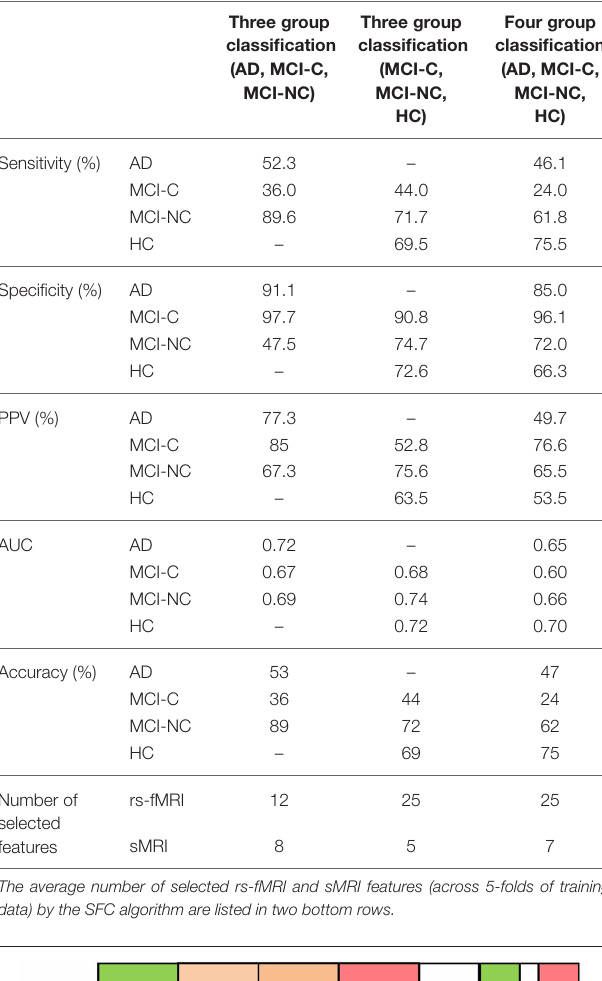
AD (6 hubs), MCI-C (5 hubs), MCI-NC (2 hubs), and HC (2 hubs). Patients with AD and MCI-C had a common hub